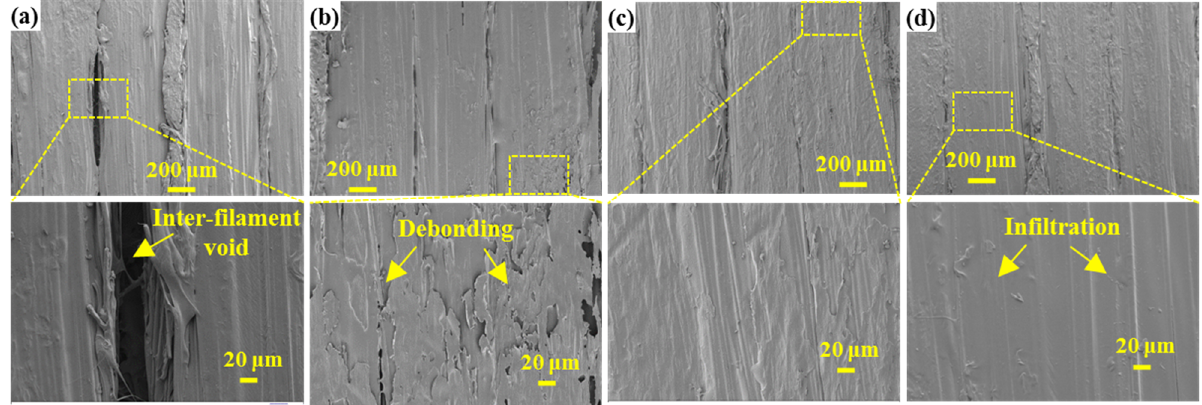
Figure 13. Microstructure of continuous-fiber layer surface under different heat treatment processes: ( a ) 150 °C-4 h; ( b ) 300 °C-4 h; ( c ) 250 °C-2 h; ( d ) 250 °C-6 h.